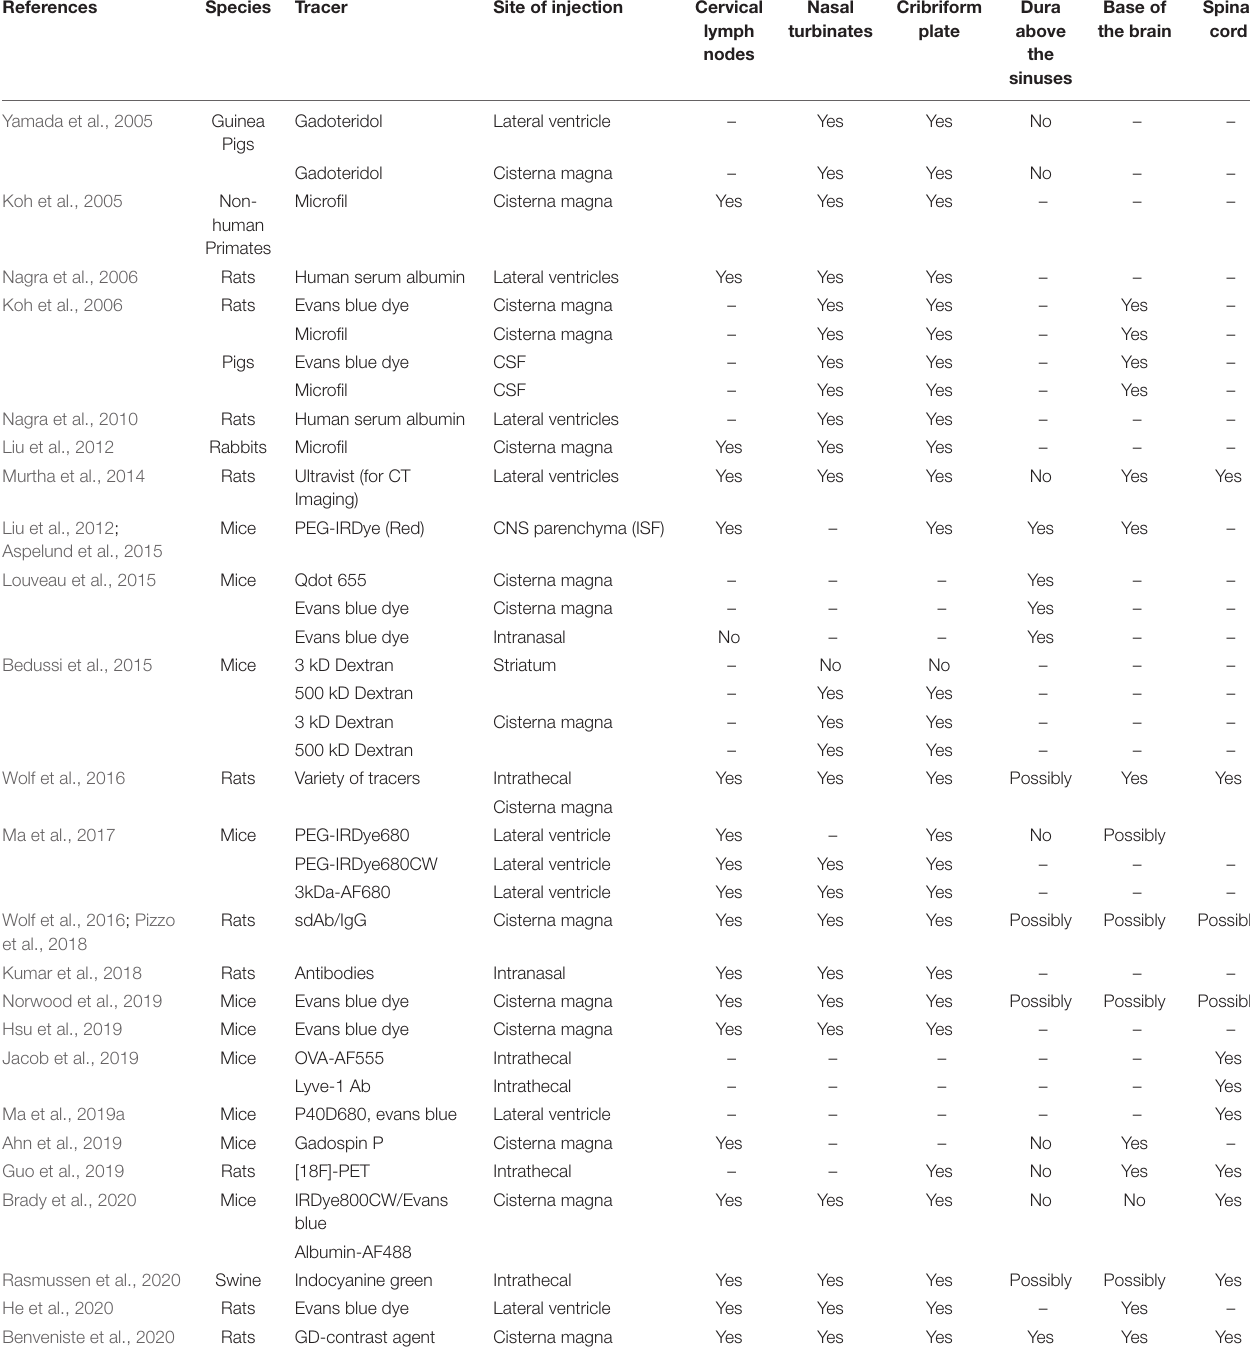
TABLE 1 | Summary of CSF drainage pathways in animal